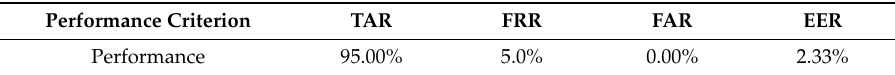
Table 3. Performance evaluation of the proposed access control system on newly collected facial images and videos in an indoor o ffi ce environment.